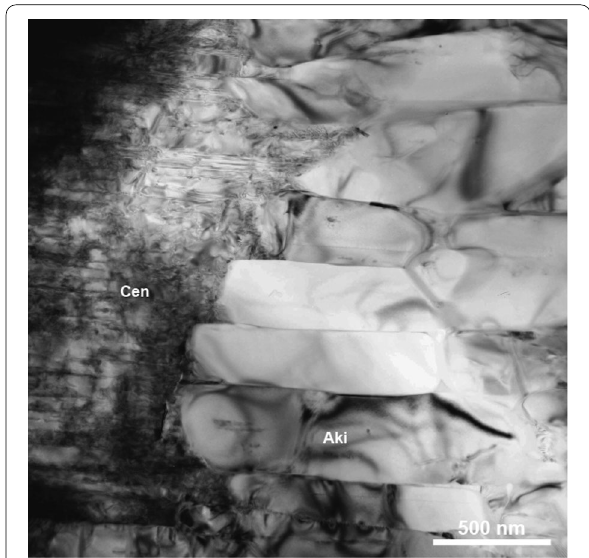
Fig. 8 BF-TEM image of akimotoite (Aki) in the Tenham L6 ordinary chondrite. The akimotoite grains formed in a solid-state transformation from low-Ca pyroxene (clinoenstatite: Cen) with (100) twin lamellae in the host rock entrapped into a shock-melt